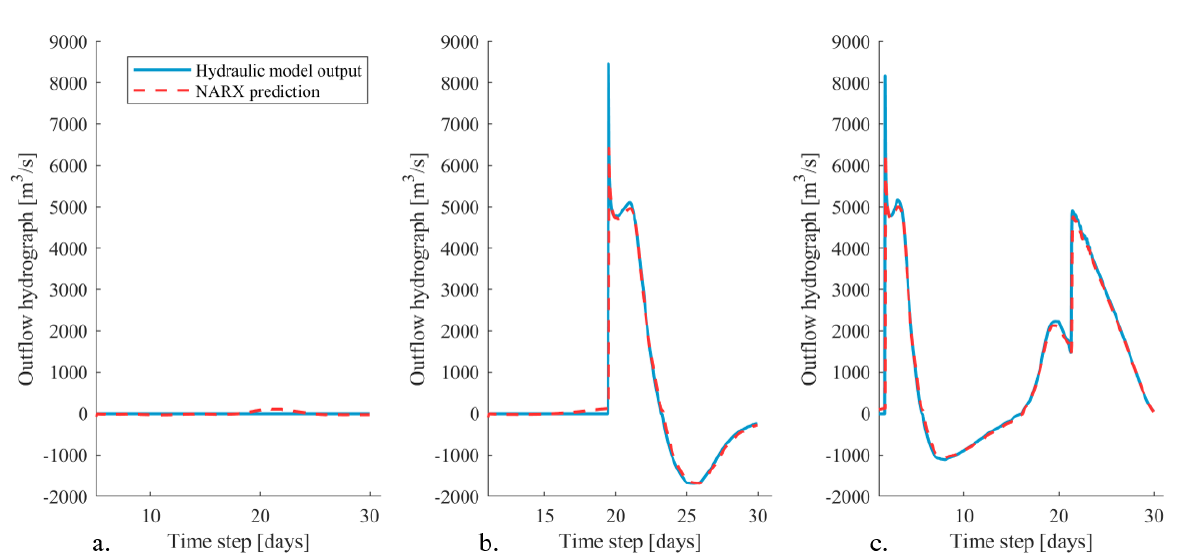
Figure 9. ( a – c ) Multiple outflow hydrographs at the most upstream dike breach location predicted by the hydraulic model and the NARX network as a result of the upstream discharge waves presented in Figure